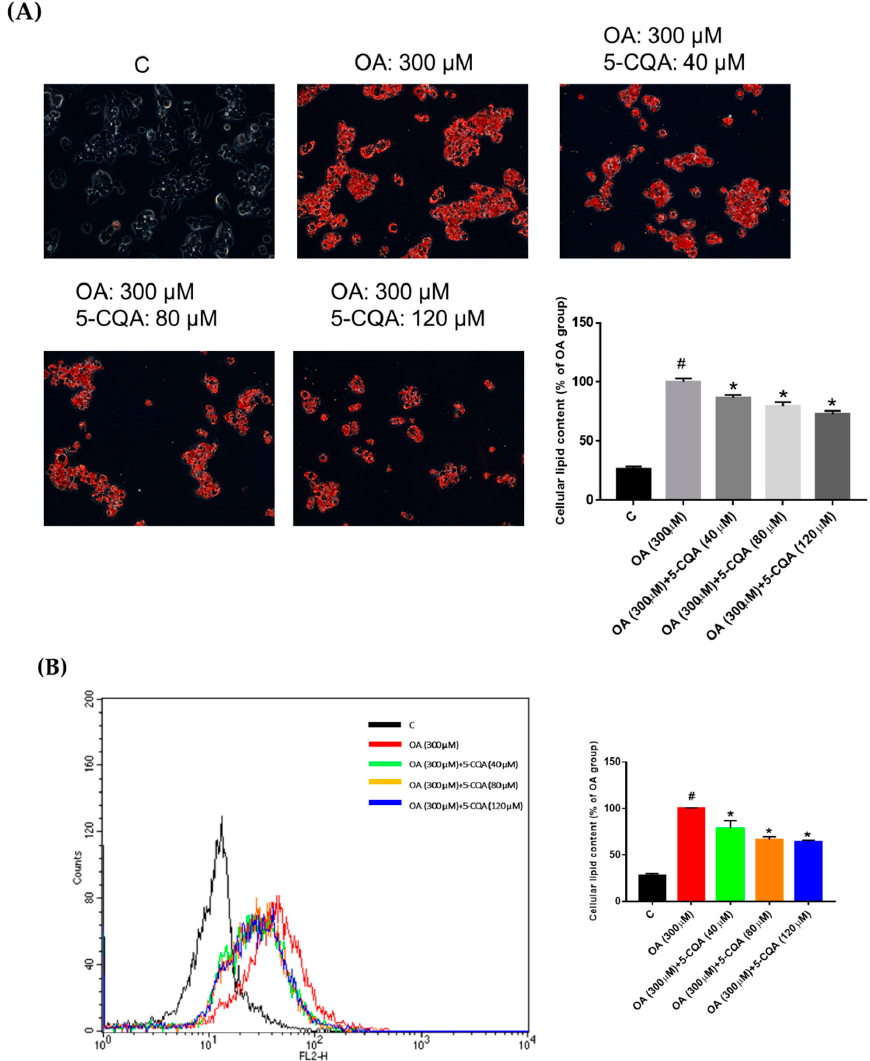
Figure 2. 5-CQA attenuated oleic acid (OA)-induced lipid accumulation in HepG2 cells. ( A ) Cultured cells demonstrated lipid accumulation induced by OA (300 μ M) for 24 h. Cells were co-treated with OA and indicated concentrations of 5-CQA (40, 80, or 120 μ M) for 24 h. Cellular neutral lipid was stained with Oil Red O and the representative photo was taken. Quantitation was determined using colorimetric analysis as described in the text. ( B ) Lipid accumulation was determined by the Nile red flow cytometry analysis. The cellular lipid content (a minimum of 10,000 cells per sample) was measured using BD biosciences FACscan with CellQuestTM Pro software. The data are expressed as mean ± SD from three independent samples for each group. # p < 0.05, in relation to the control group. * p < 0.05, in relation to the OA-induced group.